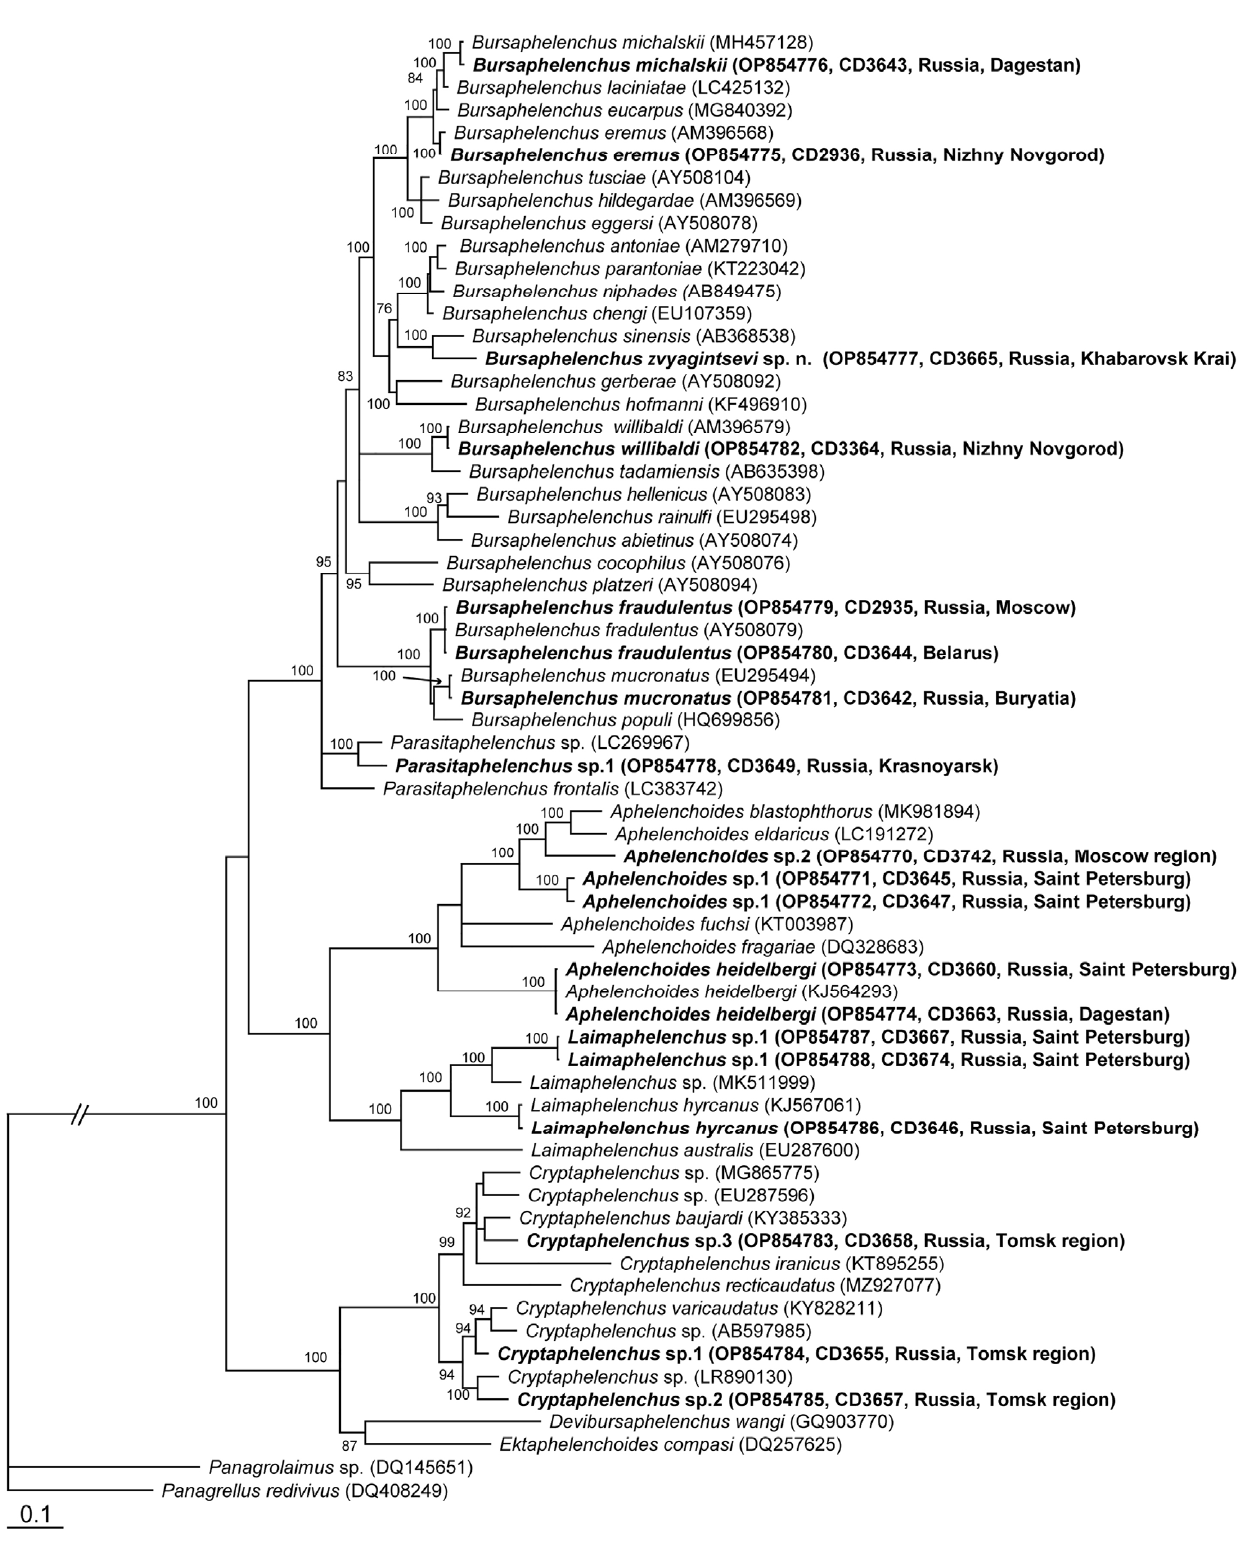
Figure 3. Phylogenetic position of the studied species relationships within some representatives from the superfamily Aphelenchoidea as inferred from Bayesian analysis of the D2–D3 of 28S rRNA gene sequences (ntax = 65 nchar = 913). Posterior probability values more than 70% are given on appropriate clades. New sequences are indicated in bold.